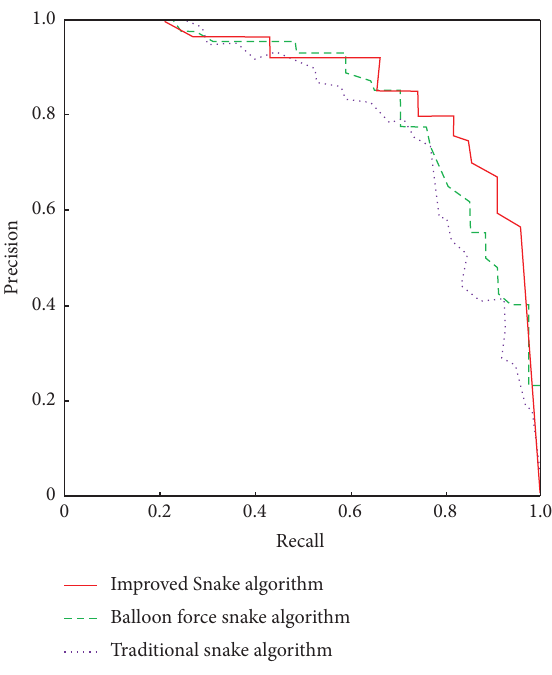
Figure 6: PR curve comparison of